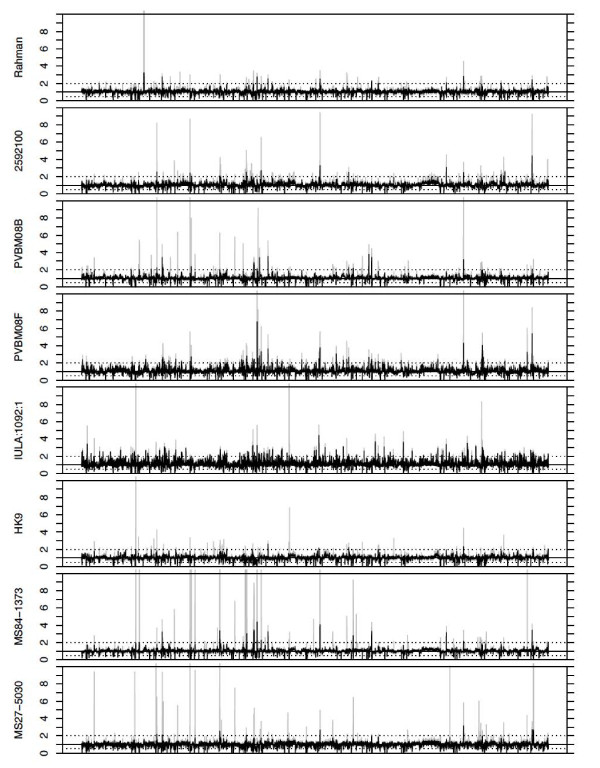
Copy number variation among E. histolytica genes. Coverage depth of a set of 6,228 E. histolytica genes relative to HM-1:IMSS in eight sequenced strains. The y-axis displays the ratio of a strain's RPKM to the average RPKM of HM-1A and HM-1B. The x-axis represents 6,228 annotated E. histolytica genes ordered by their amoebaDB gene ID. Ratios greater than 10 were truncated for display purposes. Grey bars represent results for all uniquely aligned reads, black bars for uniquely aligned reads with unique start positions on the reference genome (see Materials and methods).